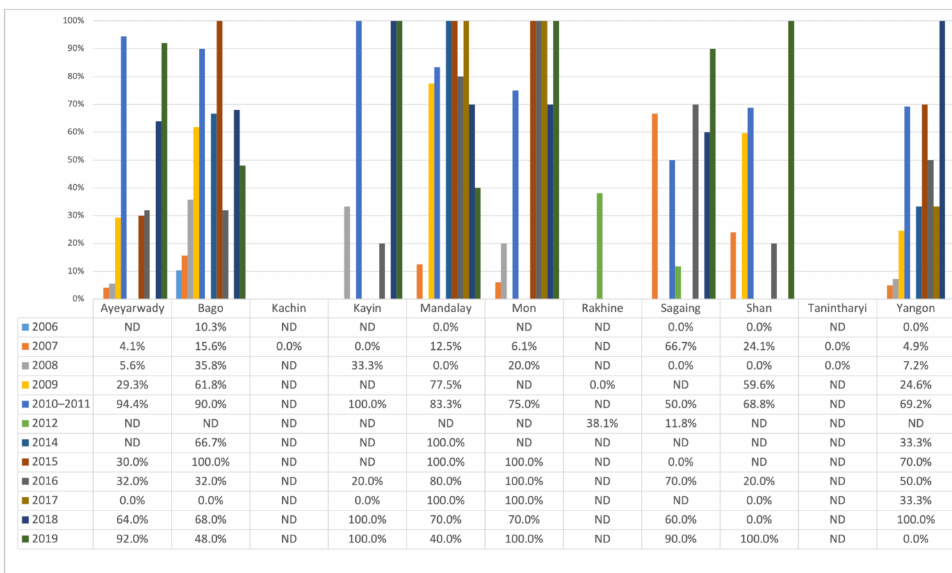
Figure 4. Annual farm sero-positivity percentage by State/Region from 2006 to